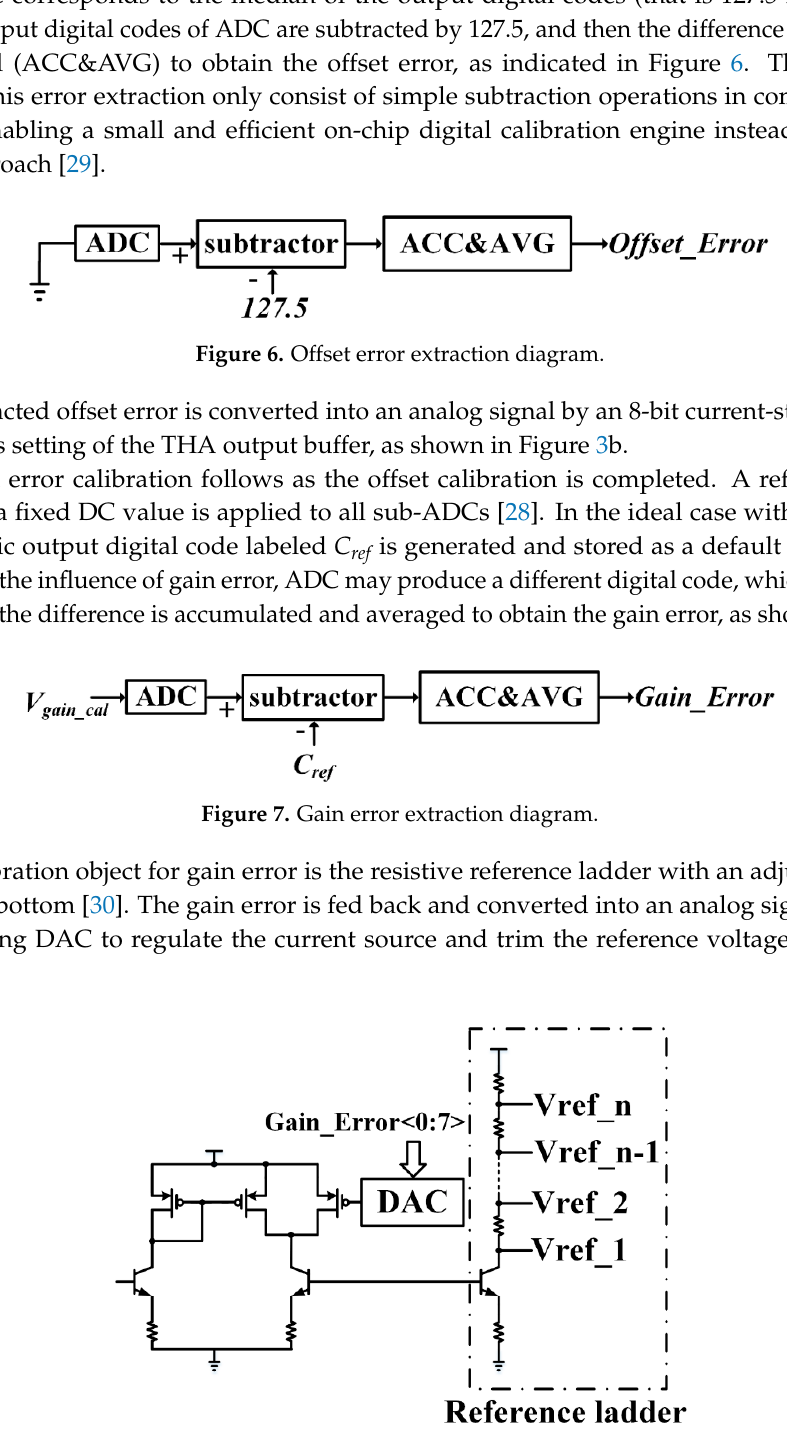
Figure 8. Reference ladder with gain error calibration interface.